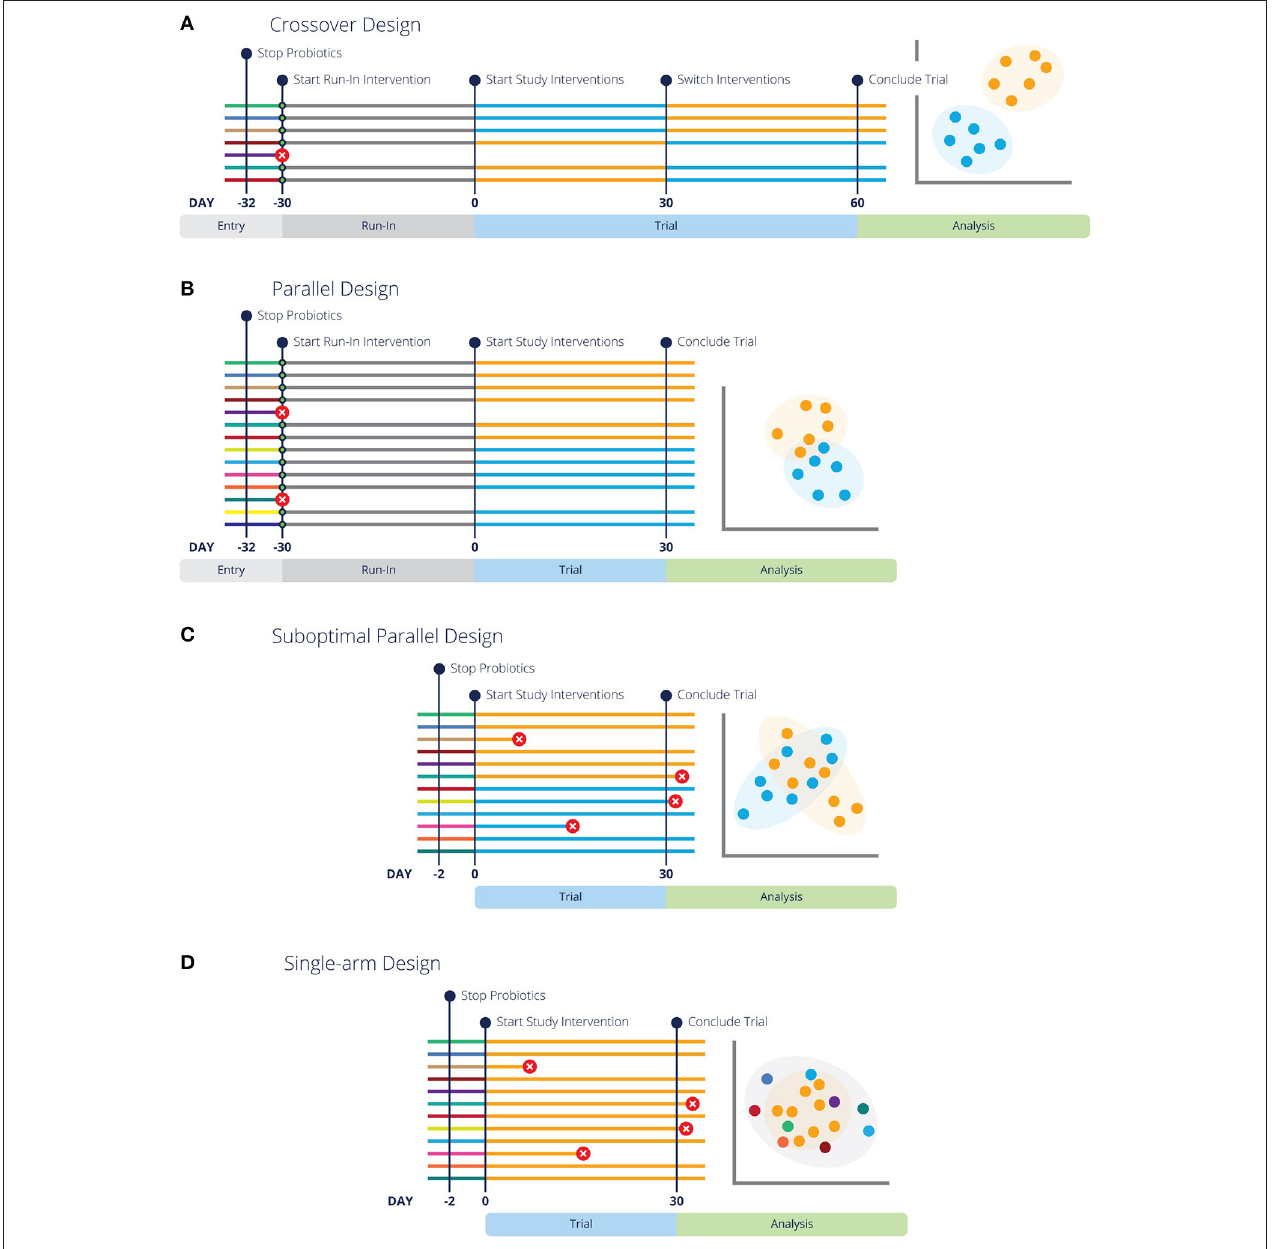
FIGURE 1 | Different experimental design strategies for feeding trials or clinical trials are more likely to have conclusive results with run-in periods and pre-screening. Each line represents a different subject in the designated trial, with colors representing respective baseline, run-in and study interventions. Green circles indicate pre-screening tests. Lines with a red circle indicate the subject is rejected by screening criteria or did not complete the trial. The analysis graphic resembles a PCoA plot (a common representation of microbiome data), with each data point representing an individual in the study. Data points are colored by the diet or intervention at the time of sampling. (A,B) Illustrate optimal crossover and parallel study design, highlighting that entry screening and run-in periods lead to fewer dropouts and more conclusive results. Additionally, (B) Highlights the need for more subjects in a parallel design study. (C) Represents the same parallel design as (A) , but without pre-screening or a washout period, which lends to inconclusive results. Similarly, (D) illustrates a “Before vs. After” design without pre-screening or a washout period and inconclusive